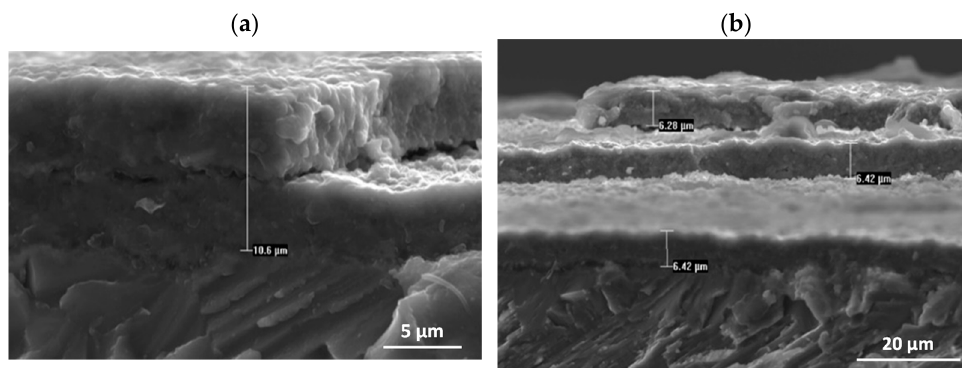
Figure 18. The cross-sectional areas of the scale formed on the alloy oxidised at 975 ° C (surface prepared by grinding): ( a ) high-magnification, ( b ) low-magnification.